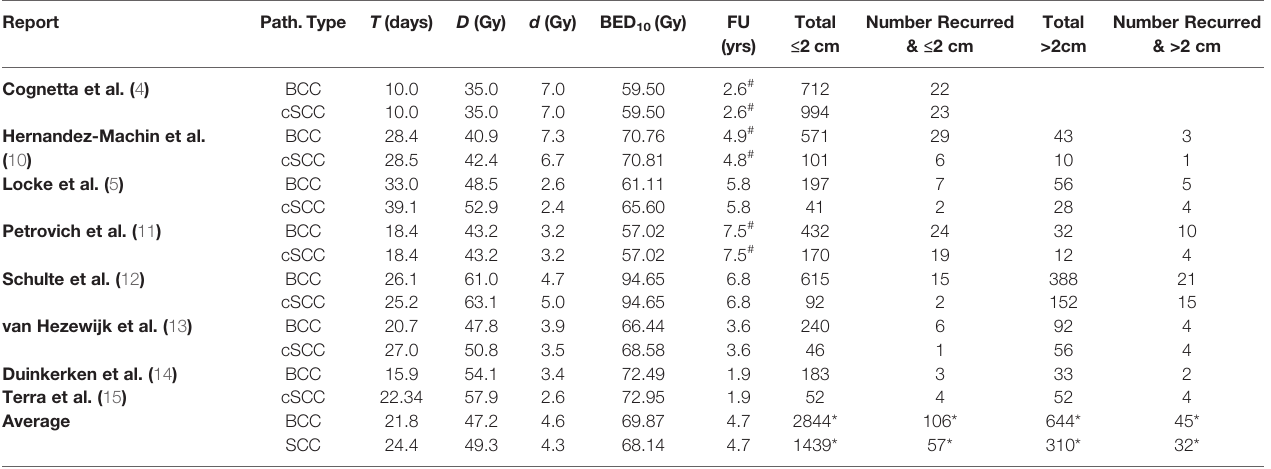
TABLE 1 | Description of studies used in the development of a tumor control probability (TCP) model for basal and cutaneous squamous cell carcinomas (BCC and cSCC, respectively) by tumor size.